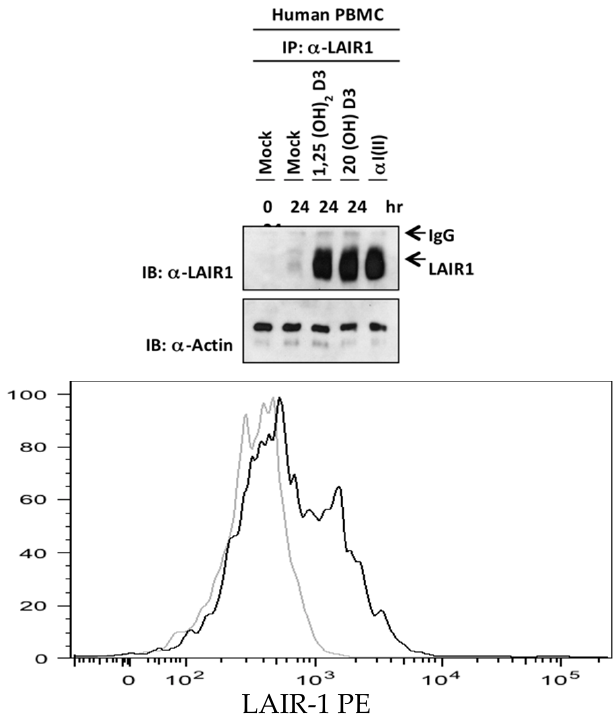
Figure 3. Stimulation of the expression of LAIR-1 by active forms of vitamin D3. (Upper panel) Hu- man PBMCs from normal volunteers were activated by Mock control (ethanol, 10 − 8 M), 1,25(OH) 2 D3 (10 − 8 M), 20 S (OH)D3 (10 − 8 M), or α I(II) (100 μ g/mL) for 12 h. Total proteins (400 μ g/500 μ L reaction volume) were immunoprecipitated with protein A/G bead conjugated with anti-LAIR-1 (R&D Systems) antibody. Expression of LAIR-1 was examined by Western blot analysis using the anti-LAIR-1 antibody. Actin was used as input control. This experiment is representative of three separate experiments. (Lower panel) Mouse splenocytes were cultured 12 h with either vehicle control (ethanol, 10 − 8 mol/L), (light grey line, mean fluorescence [MF] 388 ± 25)), or 1,25(OH) 2 D3 (10 − 8 mol/L) (black line, MF 1469 ± 42), and stained with anti-LAIR-1 for analysis by flow cytometry. The indicated panels were gated for CD4 +